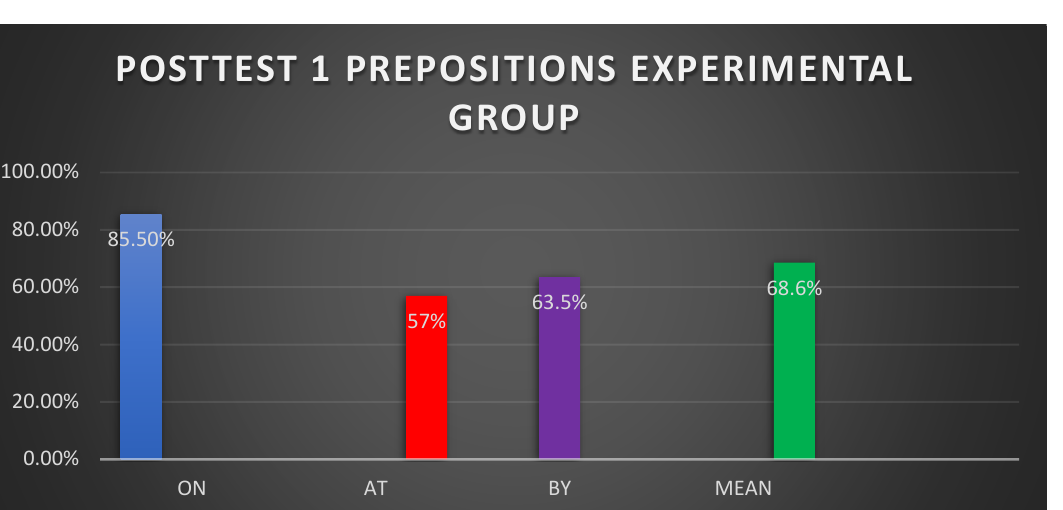
Table 10. Posttest 1 results regarding gender and level of education.